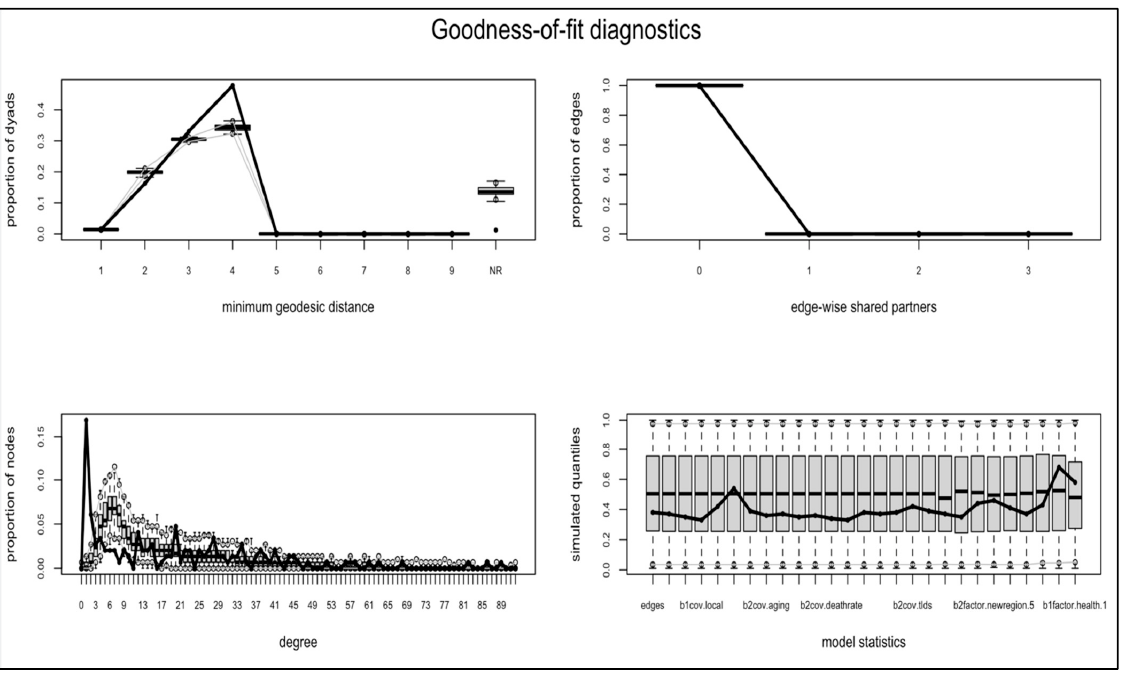
Figure 3. Goodness-of-fit analysis. Note: For each parameter and plotting, the vertical axis represents the log-odds of relative frequency, the statistics from the observed network are indicated by the solid lines, the boxplots indicate the median and interquartile ranges, and the light gray lines indicate the range in which 95 percent of the simulated observations fall [33]. A good fit can be concluded from the plot if the solid line primarily lies within the boxplots or gray lines. Table 3. Results from the bipartite ERGM.